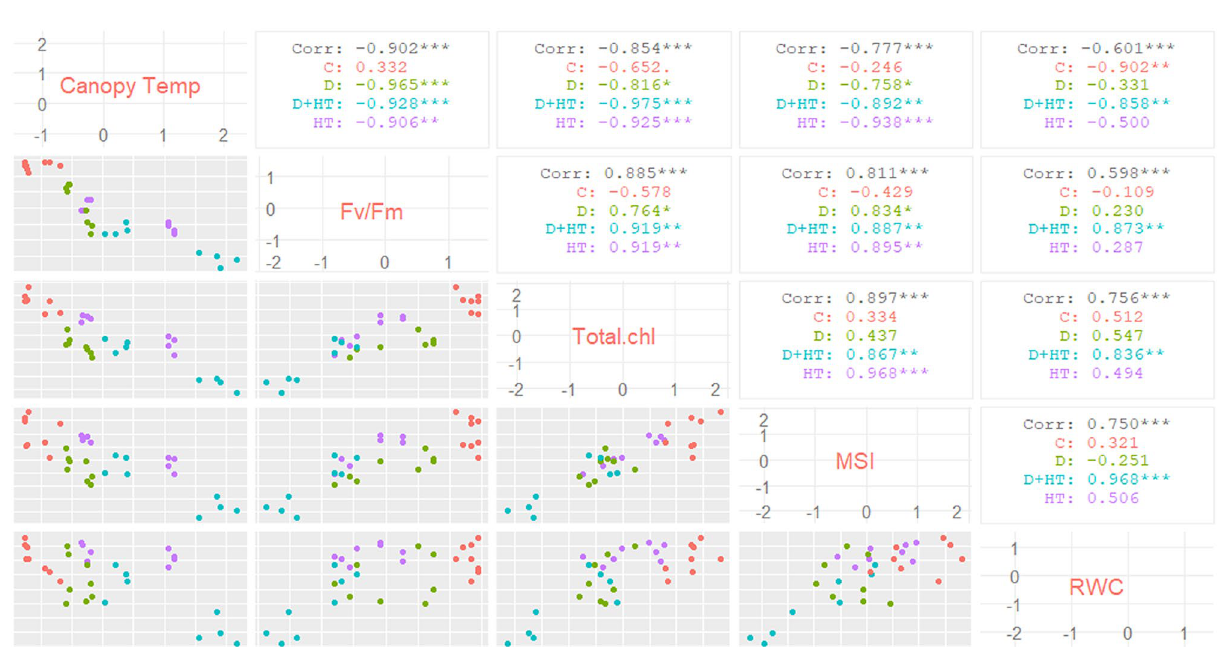
Figure 4. Scatterplots of each pair of traits recorded in the experiment. Pearson correlation is displayed on the